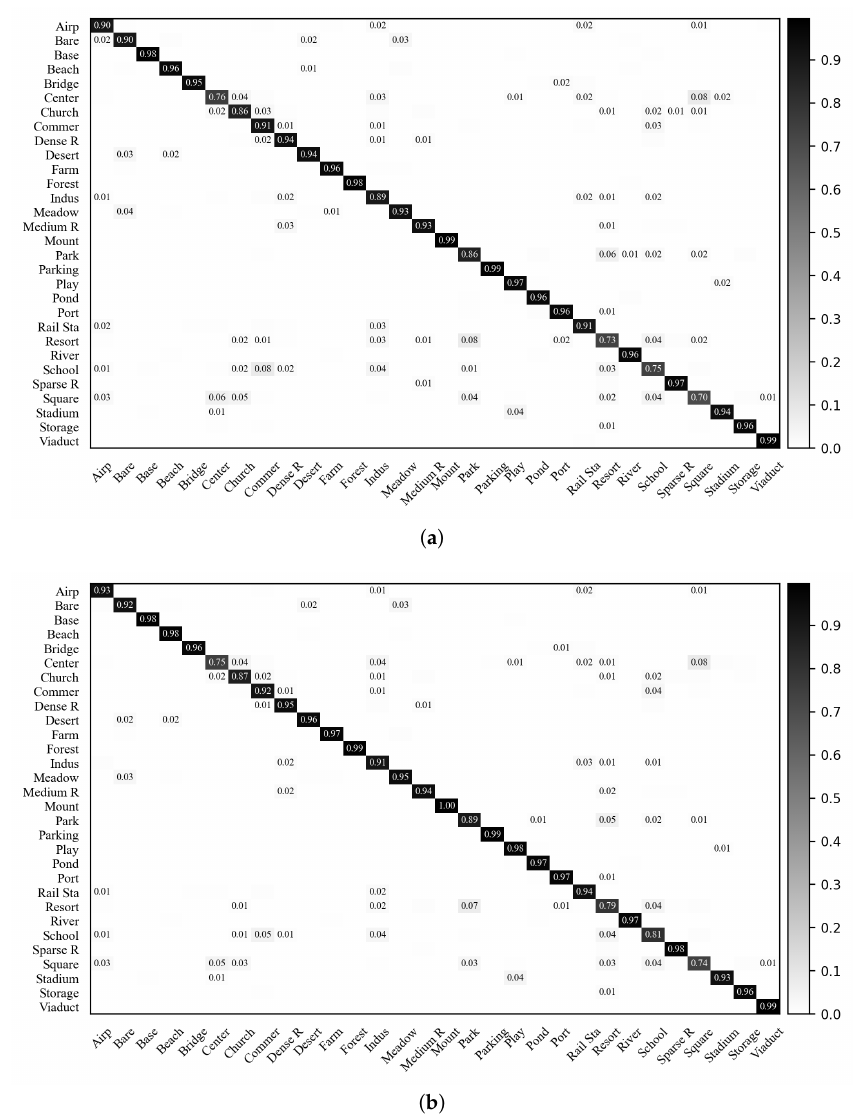
Figure 12. Confusion matrices of the VGG-VD16-based baseline DCNN and RIR-net for the AID